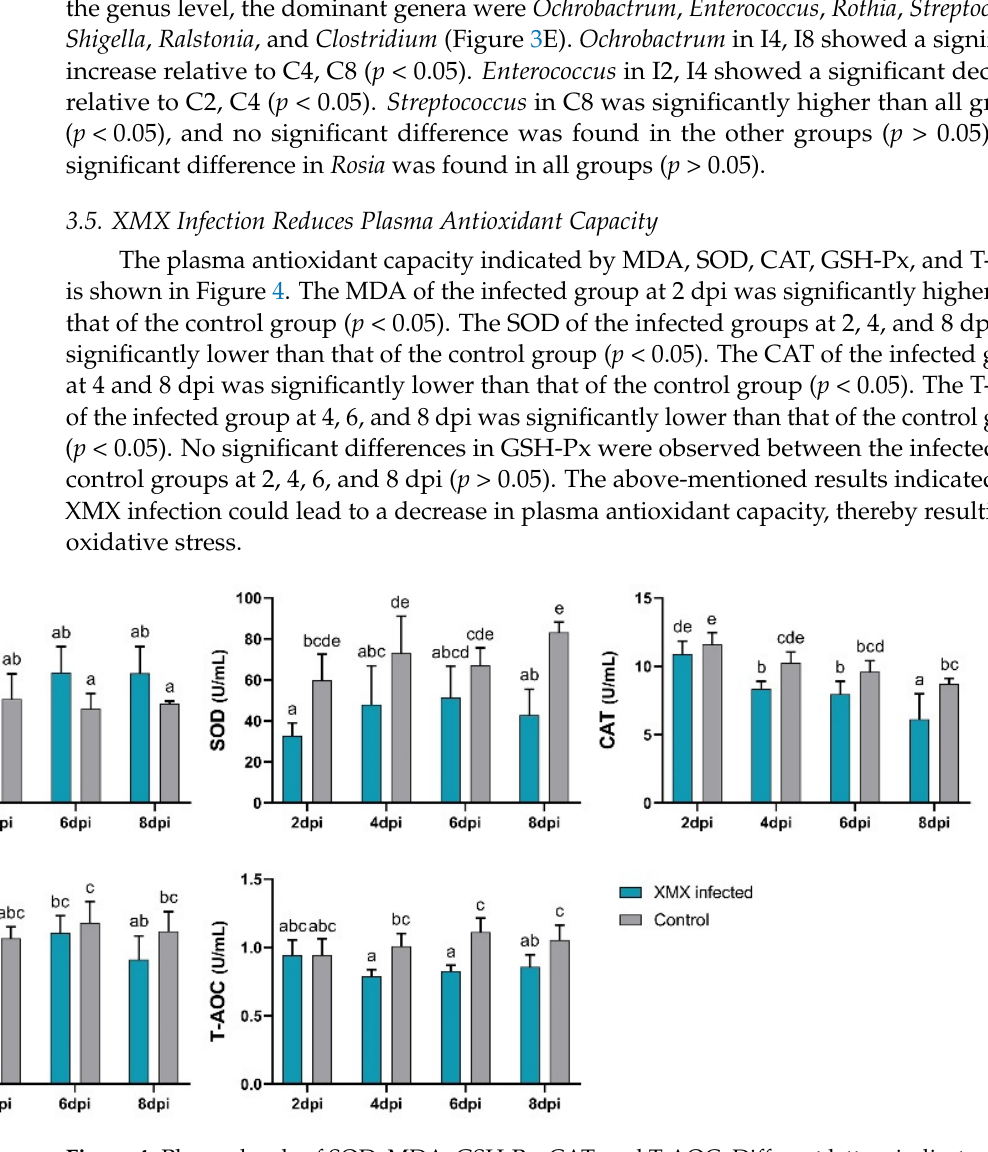
Figure 4. Plasma levels of SOD, MDA, GSH-Px, CAT, and T-AOC. Different letters indicate signifi- cant